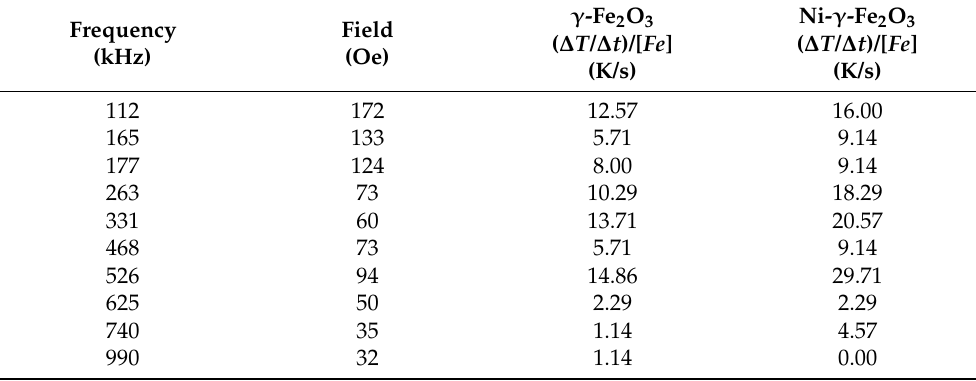
Table 5. Slope ( ∆ T / ∆ t )/Fe of the induction heating curve for HDPE films containing H-USY(40) impregnated with γ -Fe 2 O 3 and Ni– γ -Fe 2 O